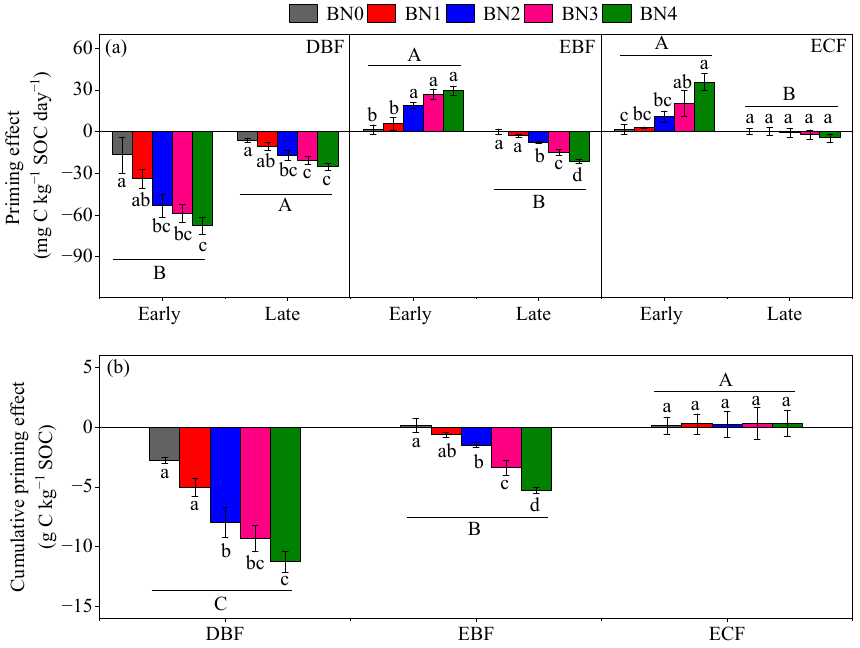
Figure 2. Effects of N addition on priming effect rate during the early and late periods ( a ) and the cumulative priming effect after a 365-day incubation ( b ) in three forests. Bars represent standard errors of the mean (n = 4). Different capital letters in figure ( a ) represent significant differences between periods. Different capital letters in figure ( b ) indicate significant differences between forests. Different lowercase letters above bars represent significant differences among treatments within periods. Significance levels are set at p < 0.05.